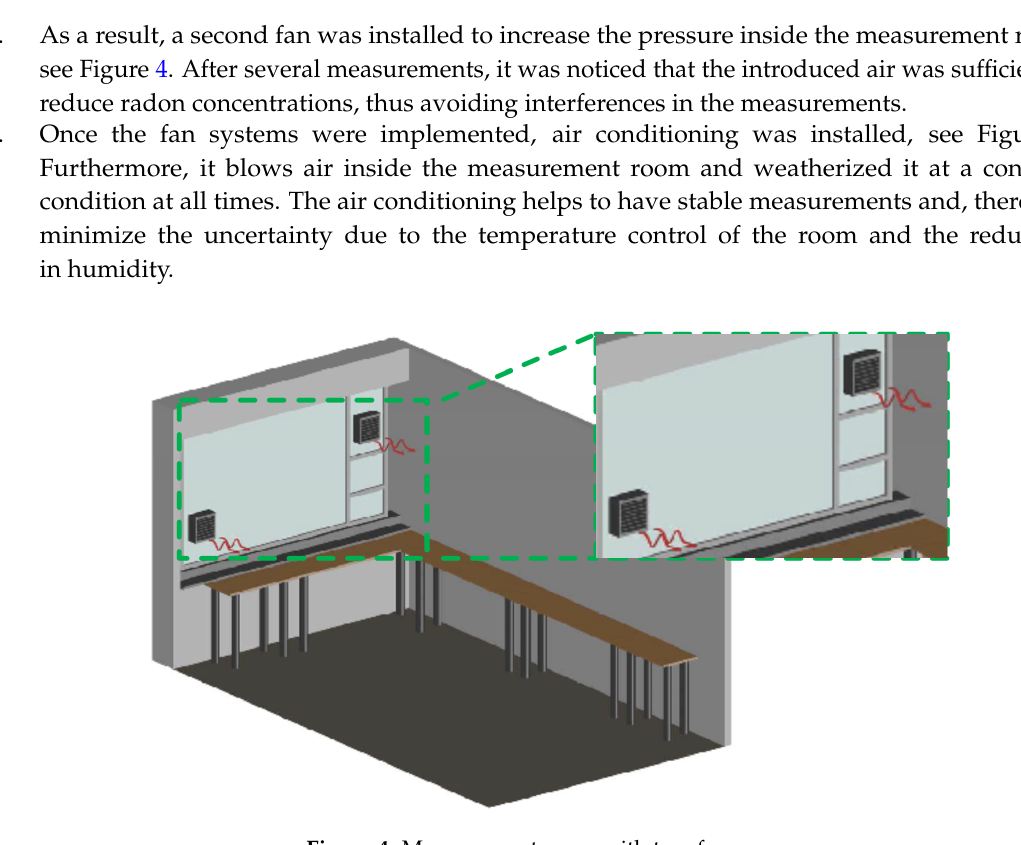
Figure 4. Measurement room with two fans.